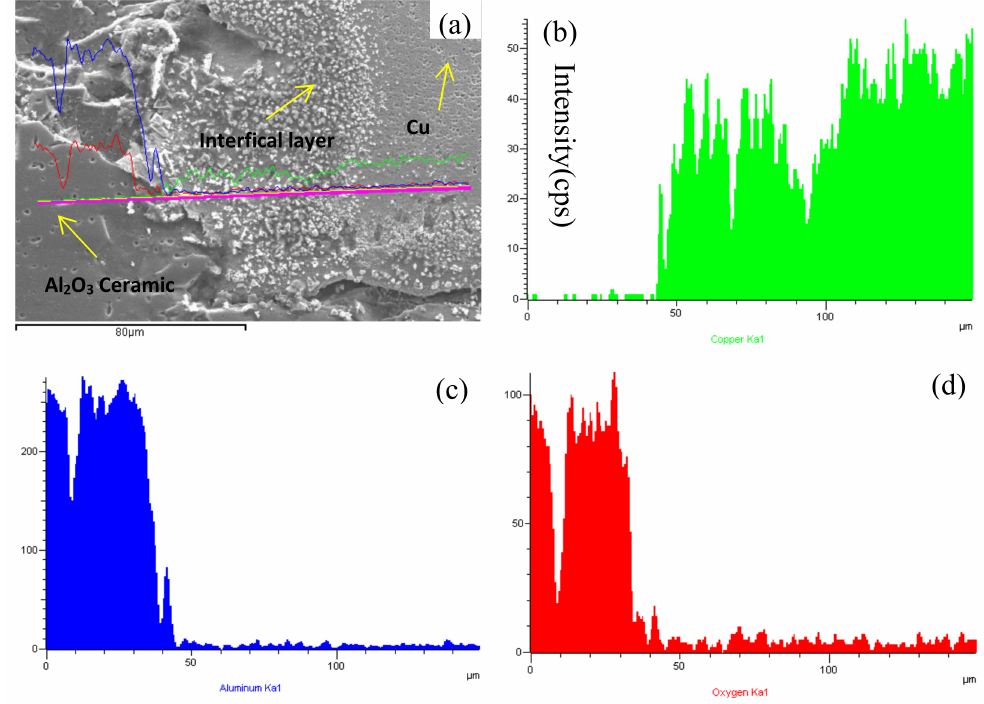
Figure 4. Energy-dispersive X-ray spectroscopy (EDS) of Cu / Al 2 O 3 ceramic interface without CeO 2 : ( a ) interface, ( b ) Cu, ( c ) Al, ( d )